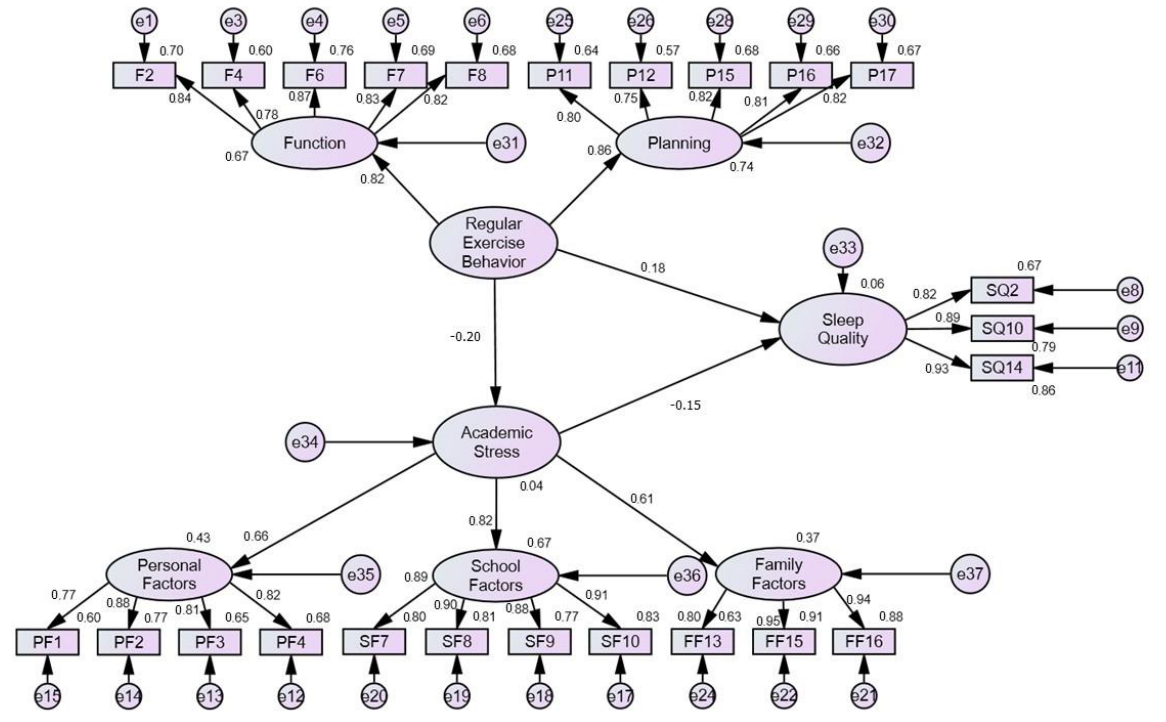
Figure 2. Model of impact of regular exercise behavior of college students on academic stress and sleep quality.